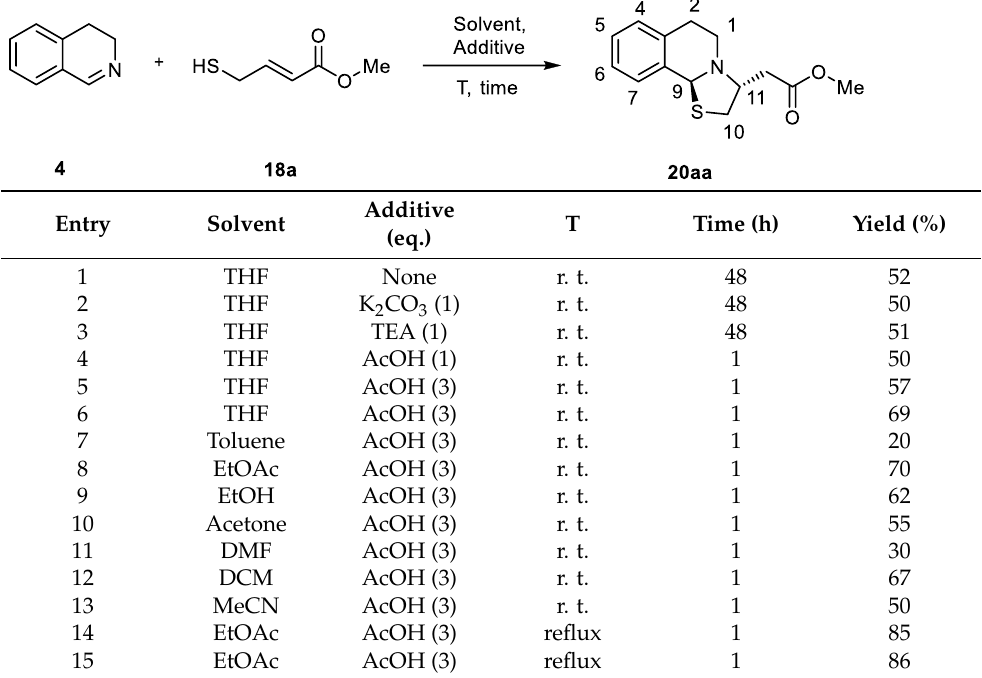
Table 1. Optimization of the addition reaction of 4a with methyl ester 18a.